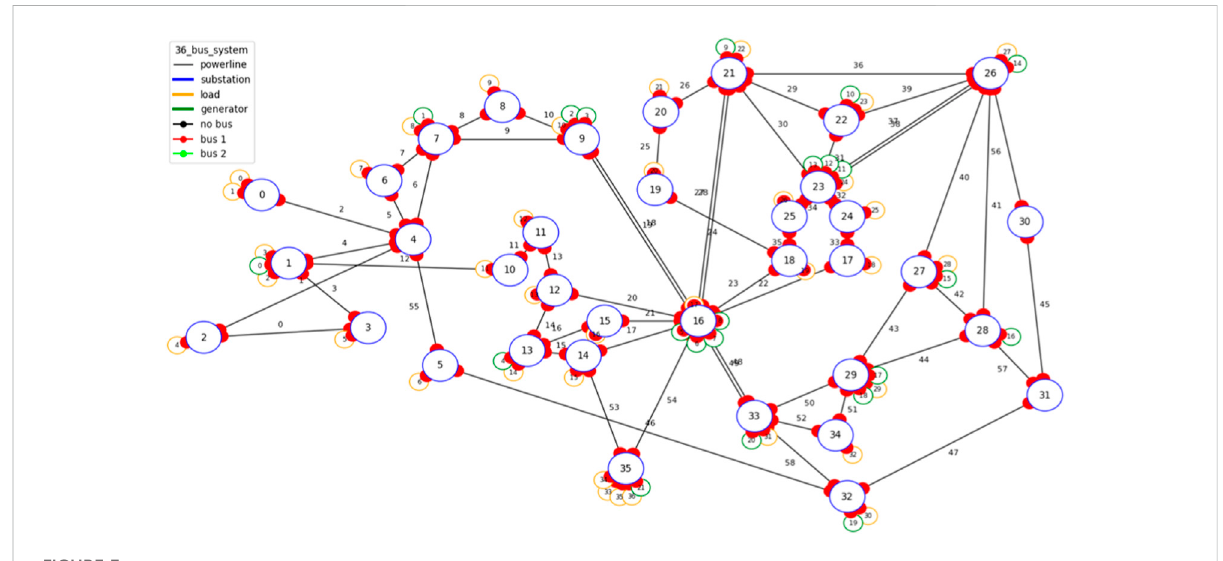
FIGURE 3 The modi fi ed 36-bus